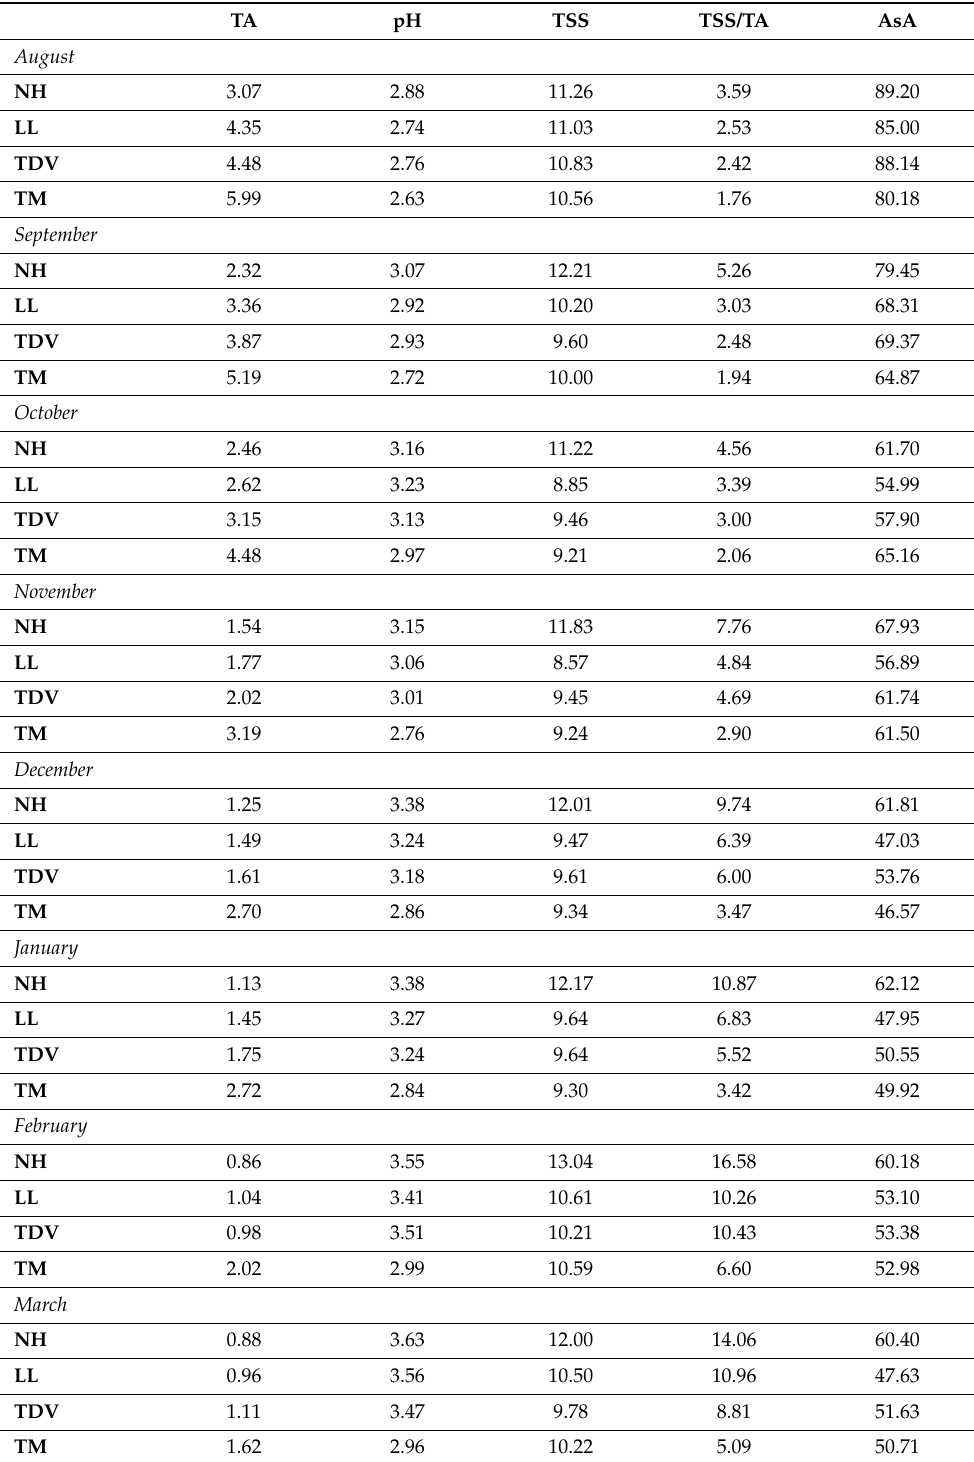
Table 2. Analysis of five parameters measured in navel and pigmented oranges. Changes in TSS, TA, TSS/TA ratio, and AsA (mg/100 mL) in fruits of Newhall (NH), Lanelate (LL), Tarocco TDV (TDV), and Tarocco Meli